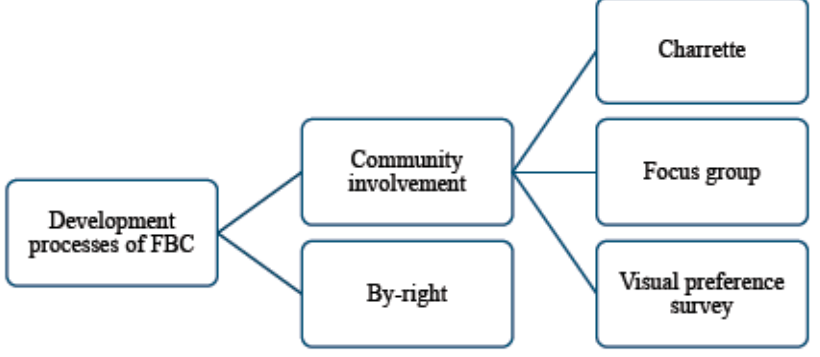
Figure 2. The different development processes of Form-Based Code Figure 2 . The different development processes of Form-Based Code (FBC).